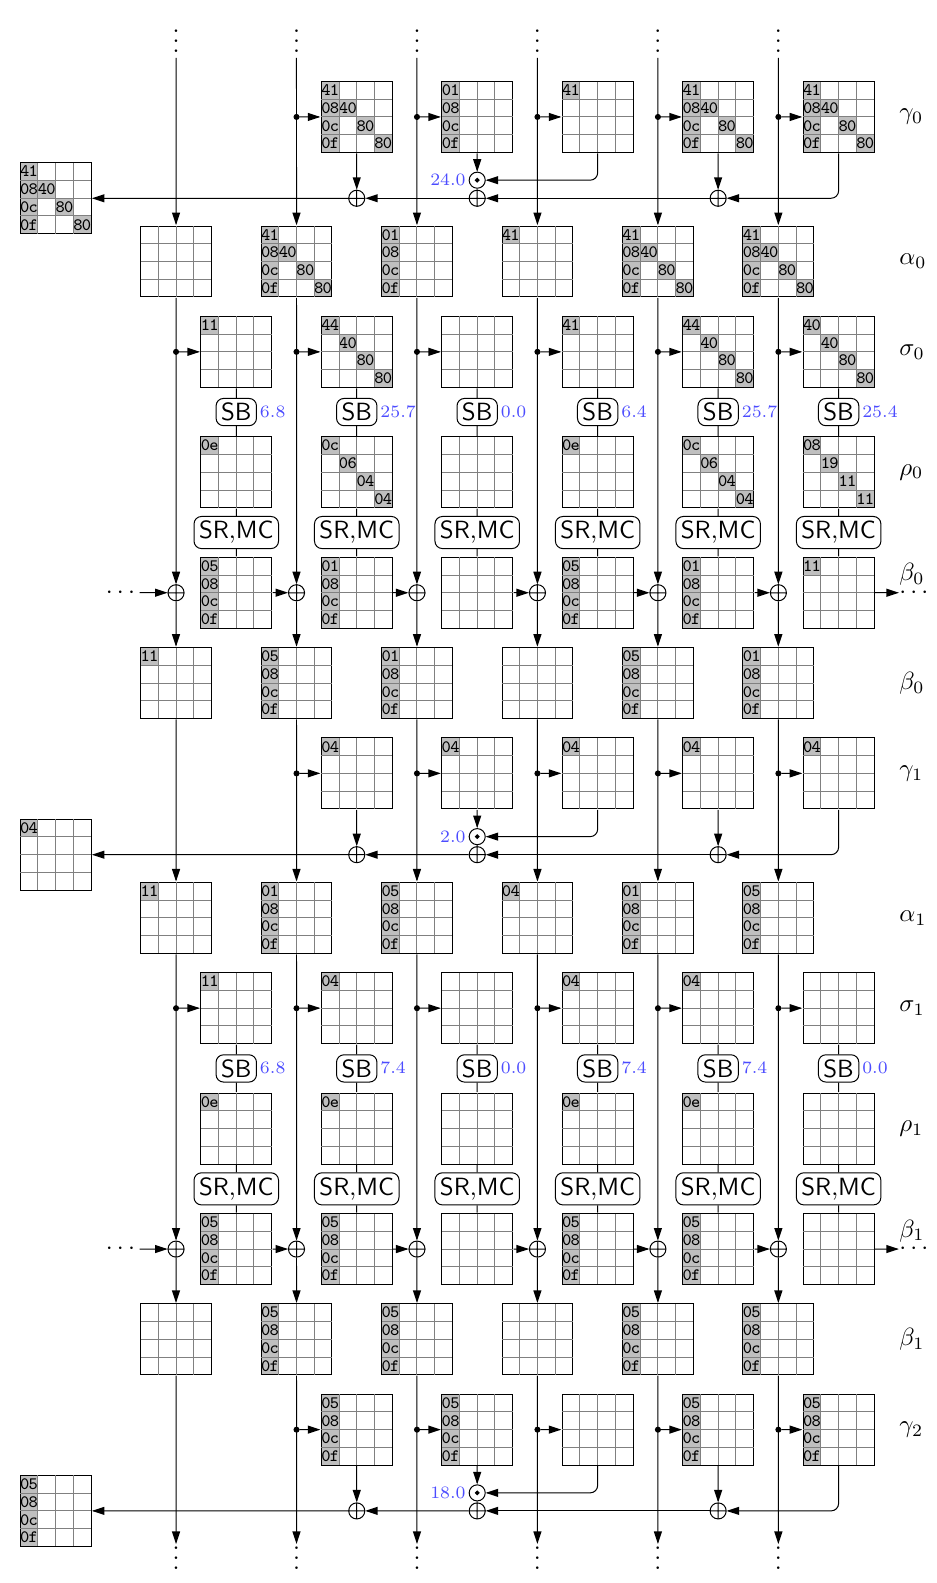
Figure 6: Linear approximation for AEGIS -256 with squared correlation contribution 2 − 162